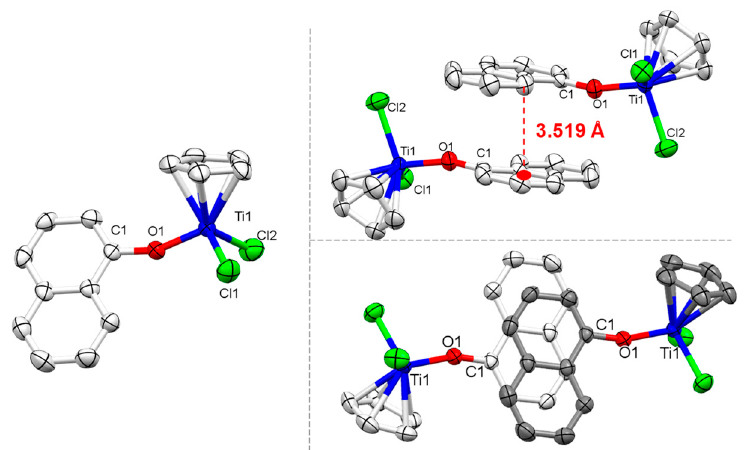
Figure 1. Single crystal structure of complex Ti1 (left); side-view of the π - π stacked dimer (upper right); top-view of the π - π stacked dimer (lower right, the two naphthalenyl rings were drawn in different color to give a clearer distinguishability). Selected bond length (Å) and angles (°): Ti1-Cl1, 2.2517(10), Ti1-Cl2, 2.2764(10), Ti1-O1, 1.7788(15), O1-C1, 1.365(2), Cl1-Ti1-Cl2, 102.53(5), O1-Ti1-Cl1, 103.76(6), O1-Ti1-Cl2, 102.39(7), C1-O1-Ti1, 158.09(13).